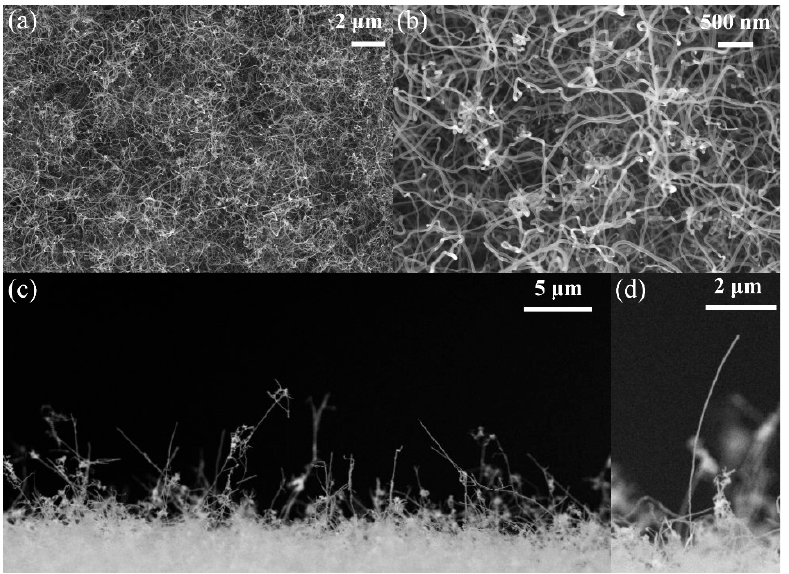
Figure 2. SEM images of the prepared CNTs. ( a , b ) The overview morphology under different magnifications. ( c ) The cross-sectional view of grown CNTs. ( d ) SEM image of one protruding CNT.